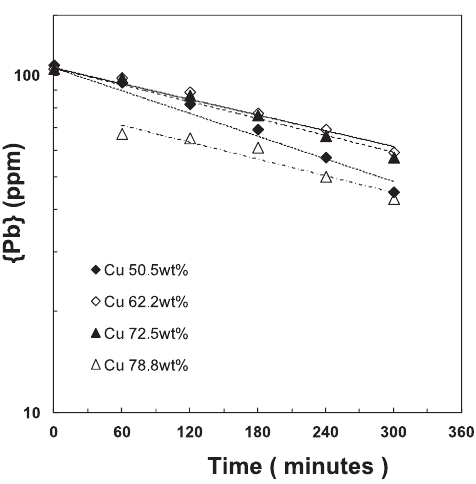
Fig. 5: Change in Pb content of the matte with time for different Cu matte grade at 1300 °C bubbled with Ar at 100 cm 3 .min − 1